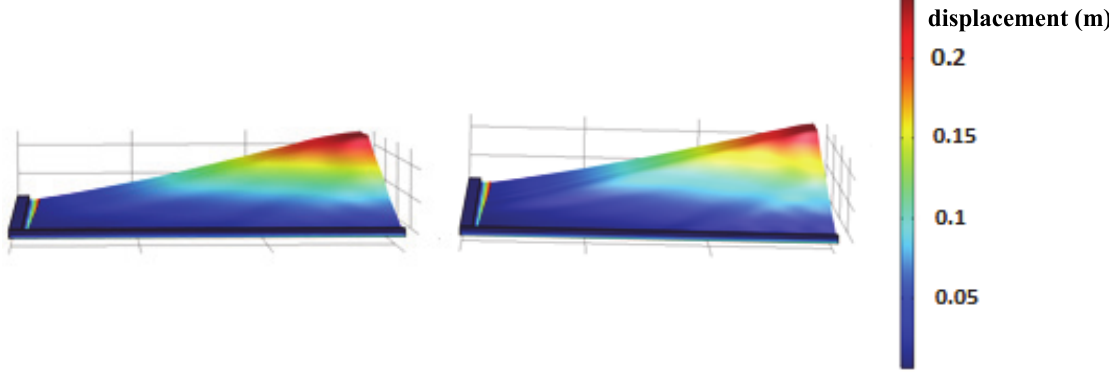
Fig. 2: Deformation profiles of broken laminate calculated using the 3 plies (left Fig.) and the 1 ply model (right Fig.) at a time corresponding to the first peak in deflection showing very similar results.